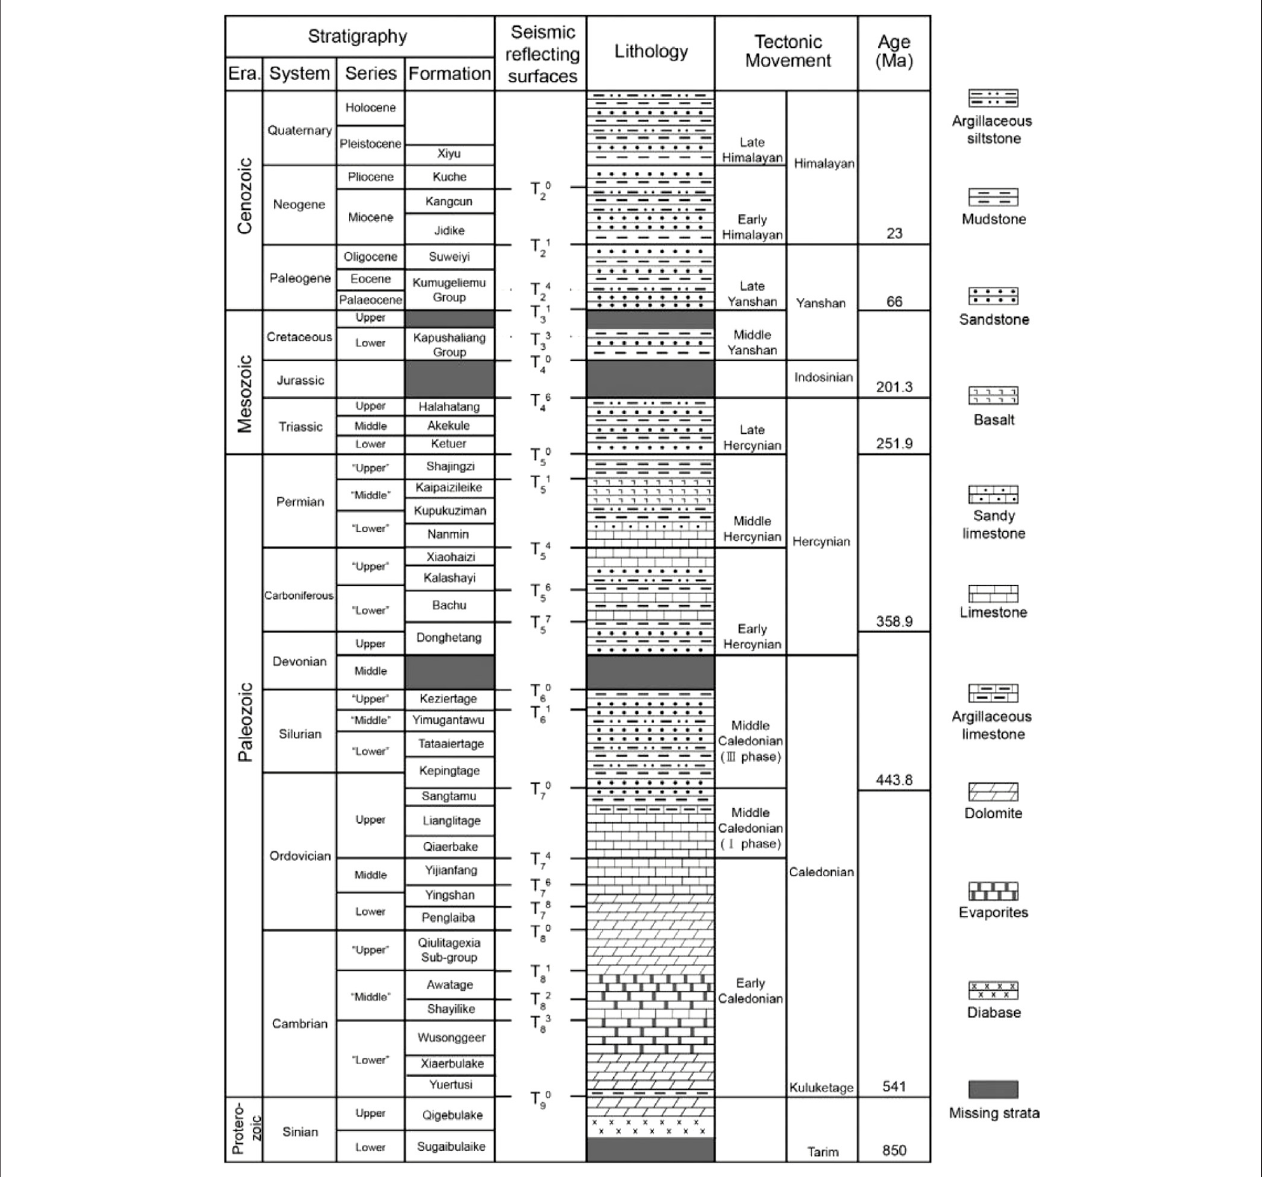
FIGURE 2 | Division of stratigraphic units in the Tarim